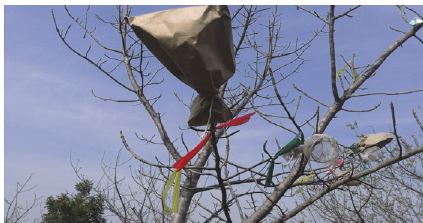
Figure 2: Mating system experiment showing three treatments randomized on the same